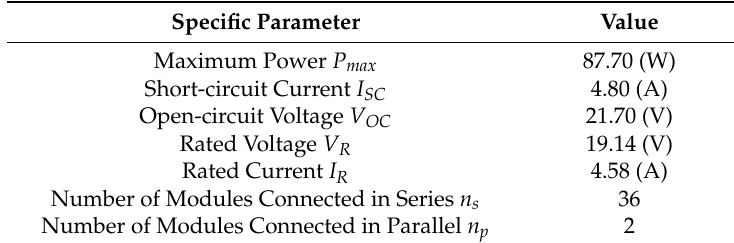
Table 2. Specific parameters of each PV panel (at solar radiation of 1.0 kW/m 2 and a temperature of 25 ◦ C) [1,3].